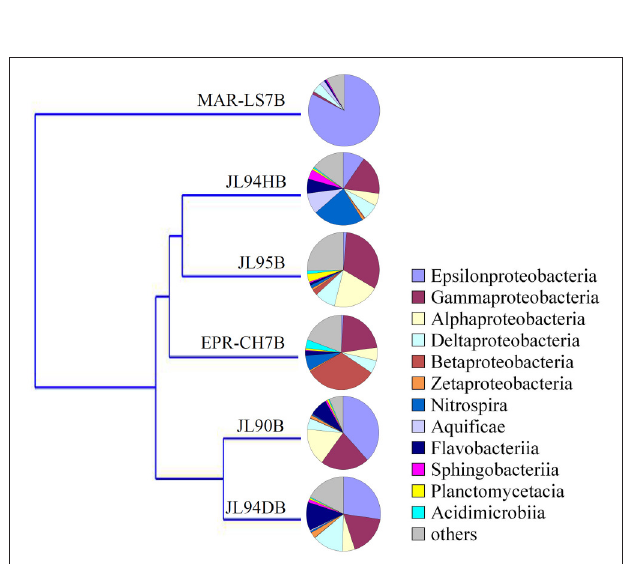
FIGURE 8 | Clustering analysis tree of the bacterial community structure of chimneys from SWIR, EPR and MAR. LS7 = Lucky Strike. Lucky Strike vent field located at MAR (Flores et al., 2011); CH7 = Chimney sample from EPR, this